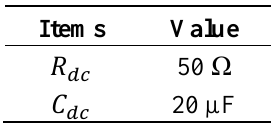
Figure 17. Fast Fourier Transformation (FFT) analysis of output voltage under Scenario 3. The parameters of the nonlinear load circuit are listed in Table 3. Table 3. Parameters of the nonlinear load